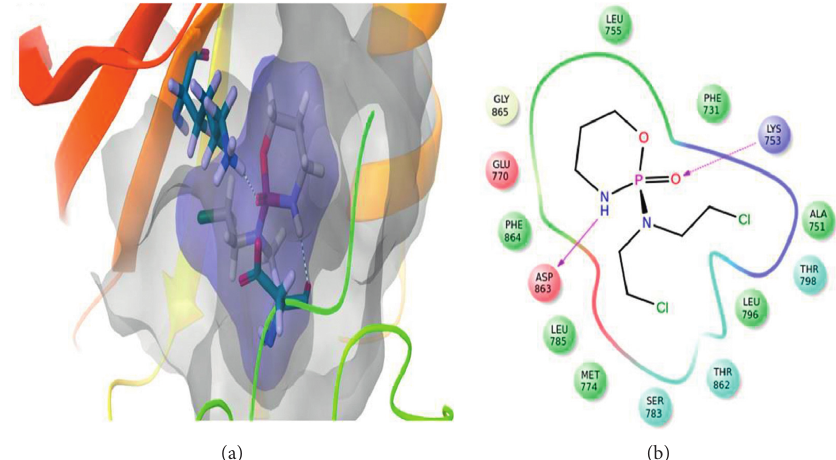
Figure 5: Docking complex of HER2 with cyclophosphamide generated using Glide XP module of Schr¨odinger suite is shown in this figure. The proteins, ligand, and binding pockets are represented in ((a) 3D graphics) ribbon, sticks, and surface models, respectively. The residues of the HER2 that are within 4 ˚A proximities to the cyclophosphamide are illustrated with (b) 2D graphics. Dotted lines denote “hydrogen bonds” between the corresponding